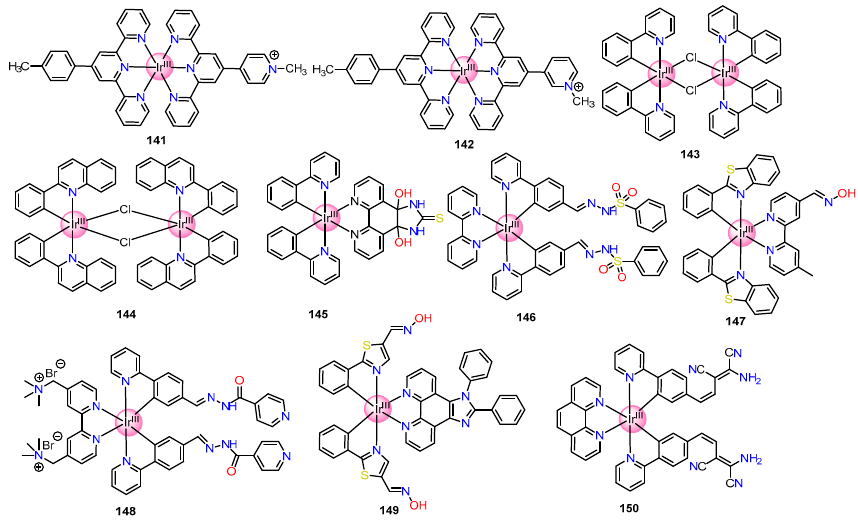
Figure 21. Structures of Ir(III) complexes 141 –